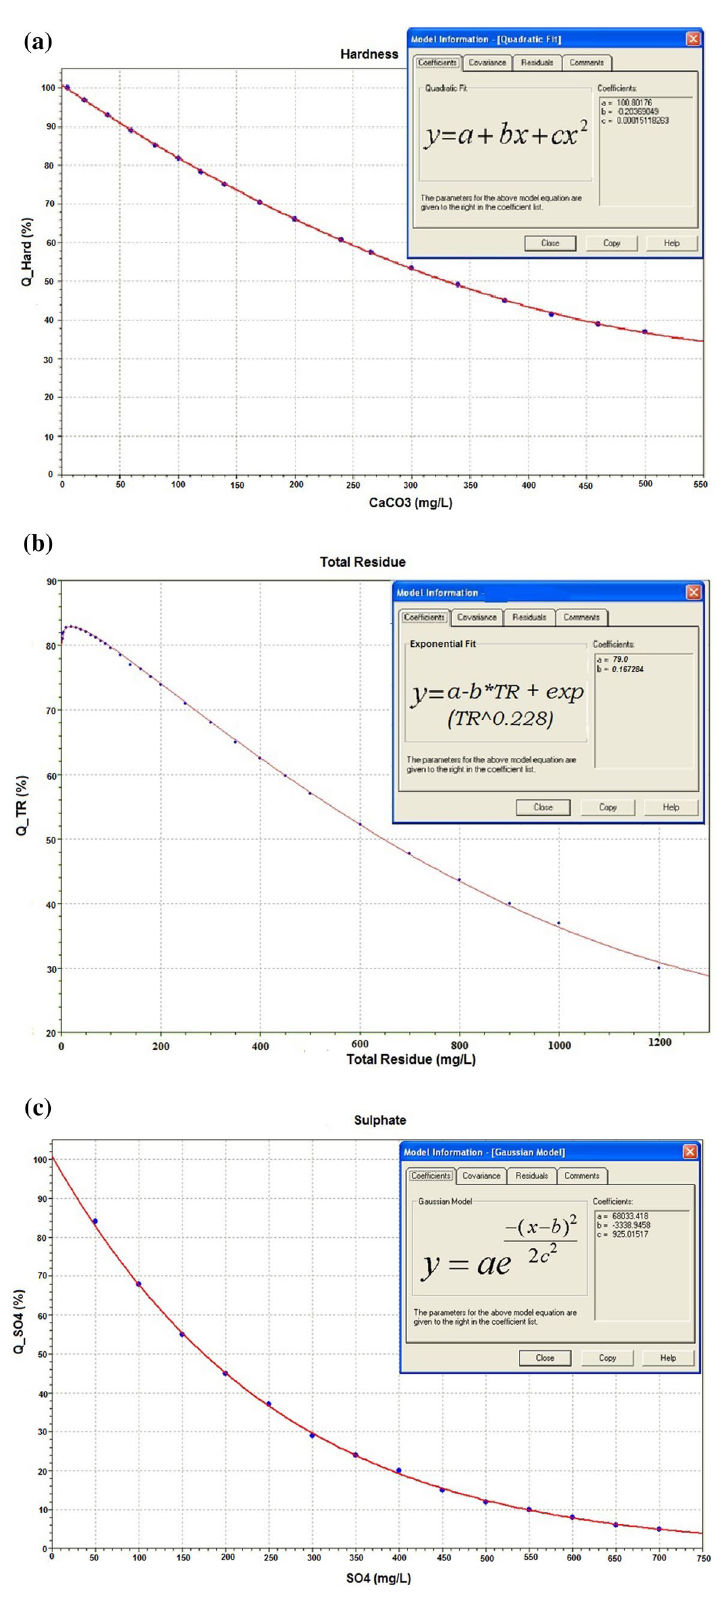
Figure 7. Nonlinear fitting models for the parameters: ( a ) hardness; ( b ) total residue; ( c ) sulphate; ( d ) fluoride; ( e ) iron; using Statgraphics, Centurion XVI 119